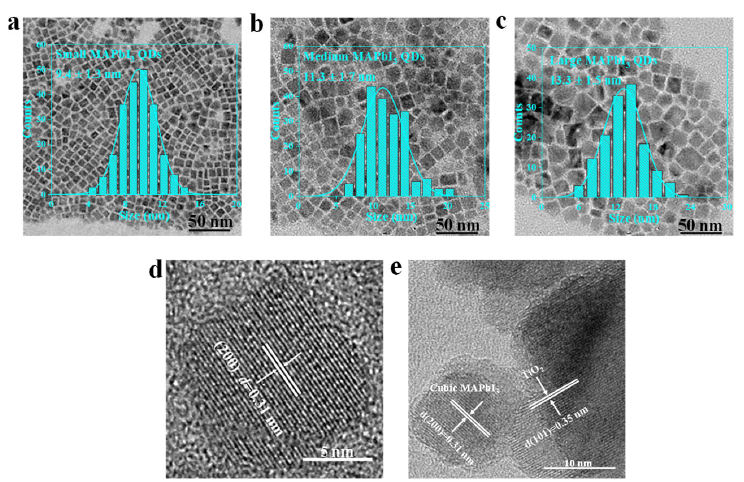
Figure 2. Transmission electron microscopy (TEM) images and corresponding size distribution histograms of ( a ) small, ( b ) medium, and ( c ) large size of MAPbI 3 QDs. ( d ) High-resolution TEM pattern of the large MAPbI 3 QD. ( e ) High-resolution TEM image of QDs/TiO 2 composite. X-ray di ff raction (XRD) measurement was performed to further identify the crystal-